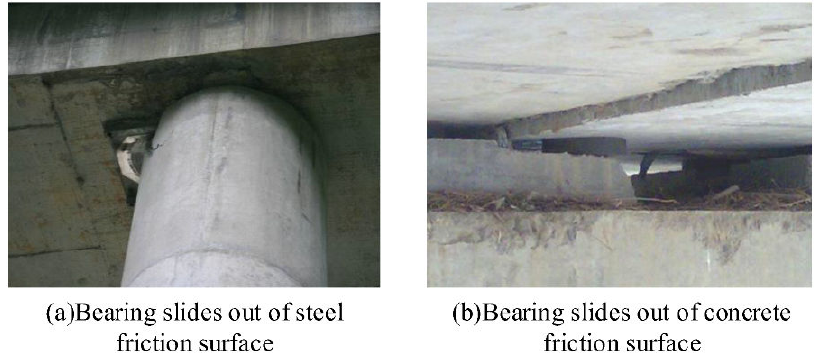
Figure 2. LRBs seismic damage in the Wenchuan